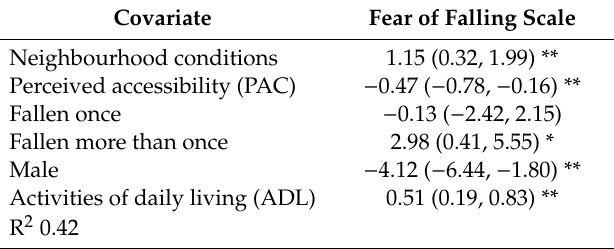
Table 5. Linear regression model for fear of